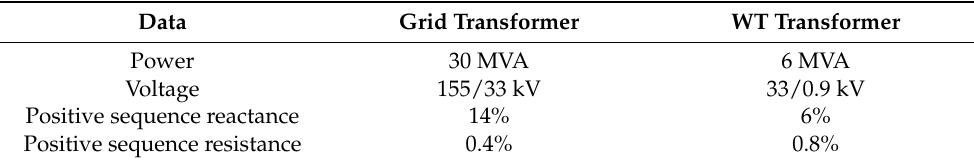
Table A1. Transformer data: 5-turbine wind power plant.